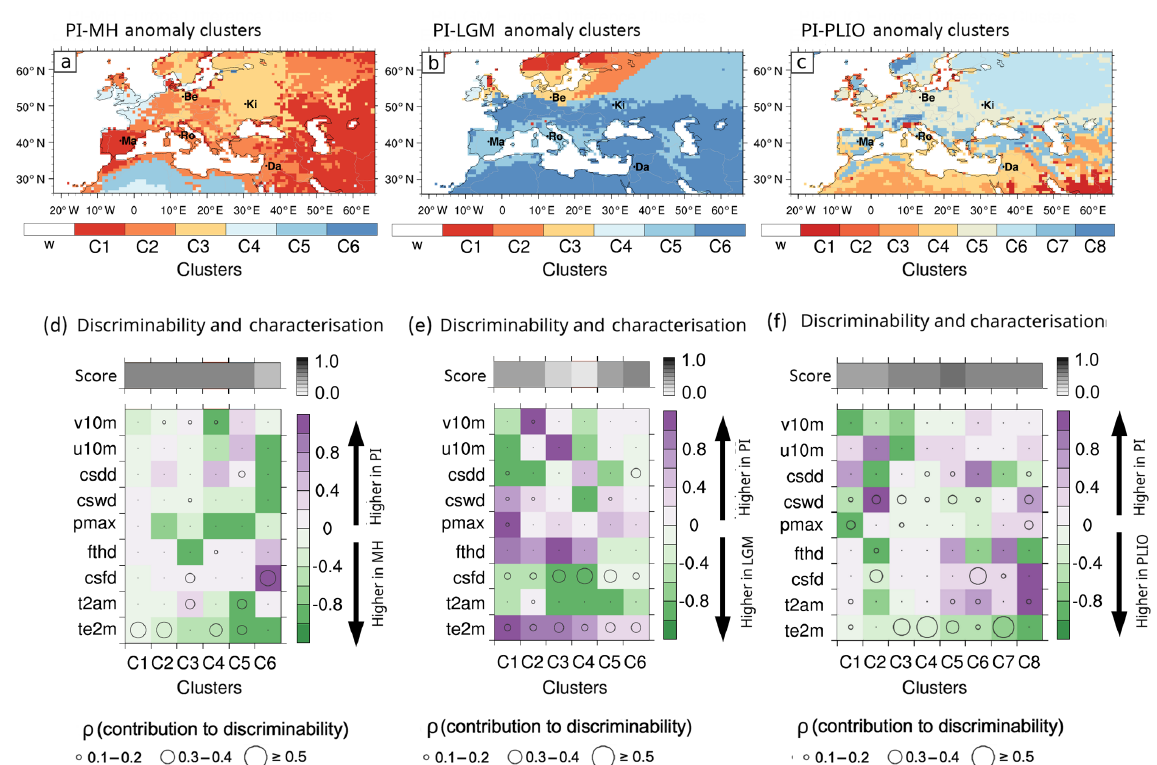
Figure 4. The multivariate anomaly maps for time slice comparisons PI–MH (a) , PI–LGM (b) and PI–PLIO (c) show the geographical cov- erage of clusters C 1 – C i in Europe, which describe the spatial extent of regions characterised by similar modes of change. The corresponding modes of change (d, e, f) for each cluster are expressed as relative changes in each of the nine investigated variables (Table 1): 2m air tem- perature (te2m), 2m air temperature amplitude (t2am), consecutive freezing days (csfd), freeze–thaw days (fthd), maximum precipitation (pmax), consecutive wet days (cswd), consecutive dry days (csdd), zonal near-surface wind speeds ( u 10) and meridional near-surface wind speeds ( v 10). The score (d, e, f) expresses the goodness of discriminability between the palaeoclimate pairs PI–MH (d) , PI–LGM (e) and PI–PLIO (f) in each of the anomaly clusters. The size of the circles corresponds to the relative contribution of each of the nine climatic attribute variables to the measured discriminability in each anomaly cluster for all three time slice